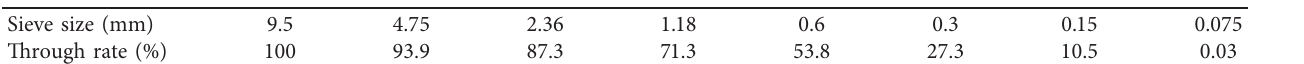
Table 3: Screening results of coral sand.